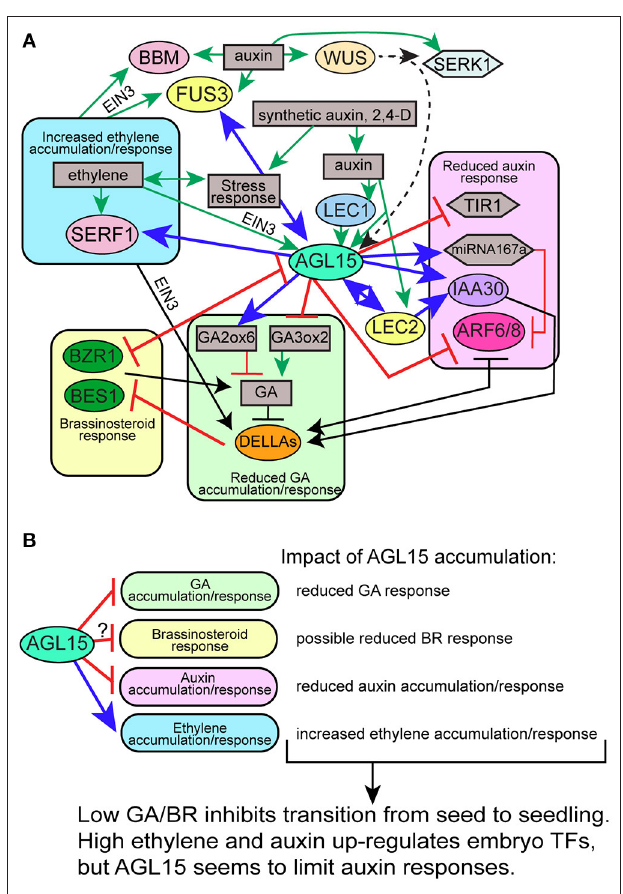
FIGURE 4 | Select interactions between TFs involved in SE and control of hormone accumulation/signaling. Not all interactions are shown in consideration of clarity. (A) Particular gene interactions; (B) summary of tested or presumed AGL15 effects on different hormones. Different colored ovals with TF names indicate different families of TFs: yellow, B3 domain; blue, CCAAT-box binding; pale pink, APETALA2 (AP2) or AP2/ERF; mint, MADS; dark green, BZR domain; lavender, AUX/IAA domain; orange, DELLA/GRAS; light orange, homeodomain. Gray boxes indicate hormone or other responses. Gray hexagon, miRNA; light blue hexagon,